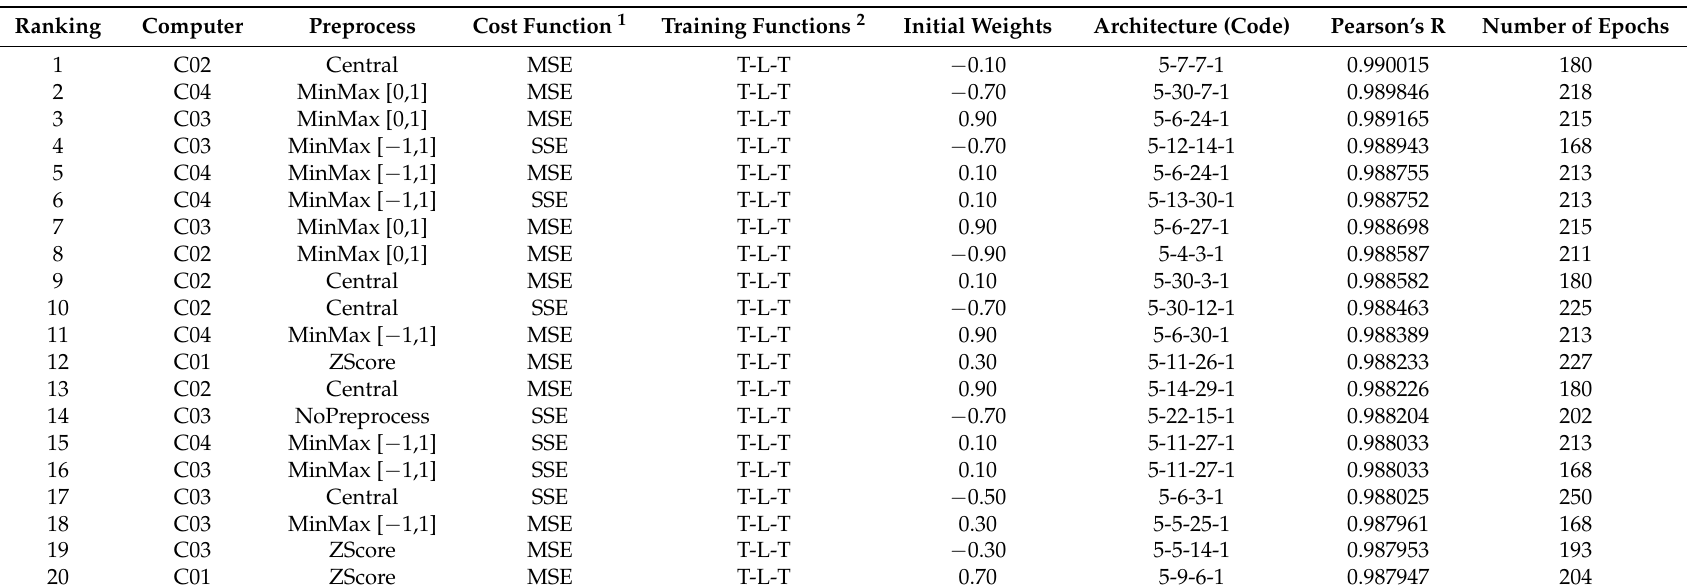
Table 3. Ranking of the top twenty best architectures of BPNNs (Compressive strength).